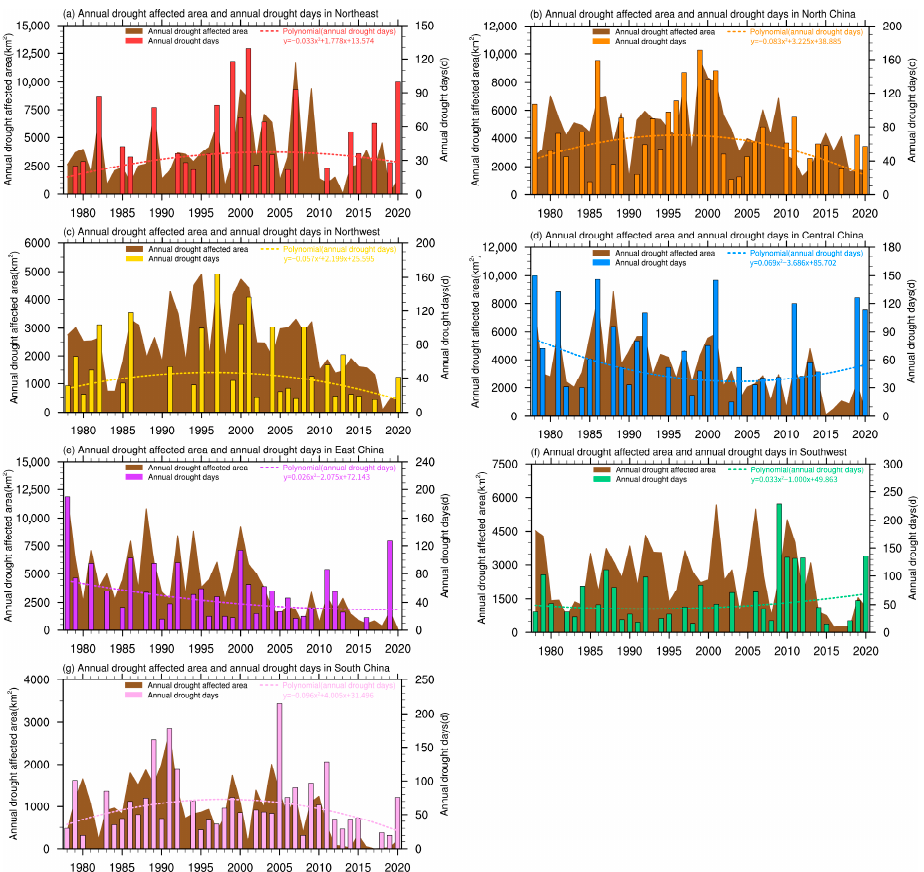
Figure 8. ( a – g ) Variation of annual average drought days and annual drought affected areas in all seven regions of China from 1978 to